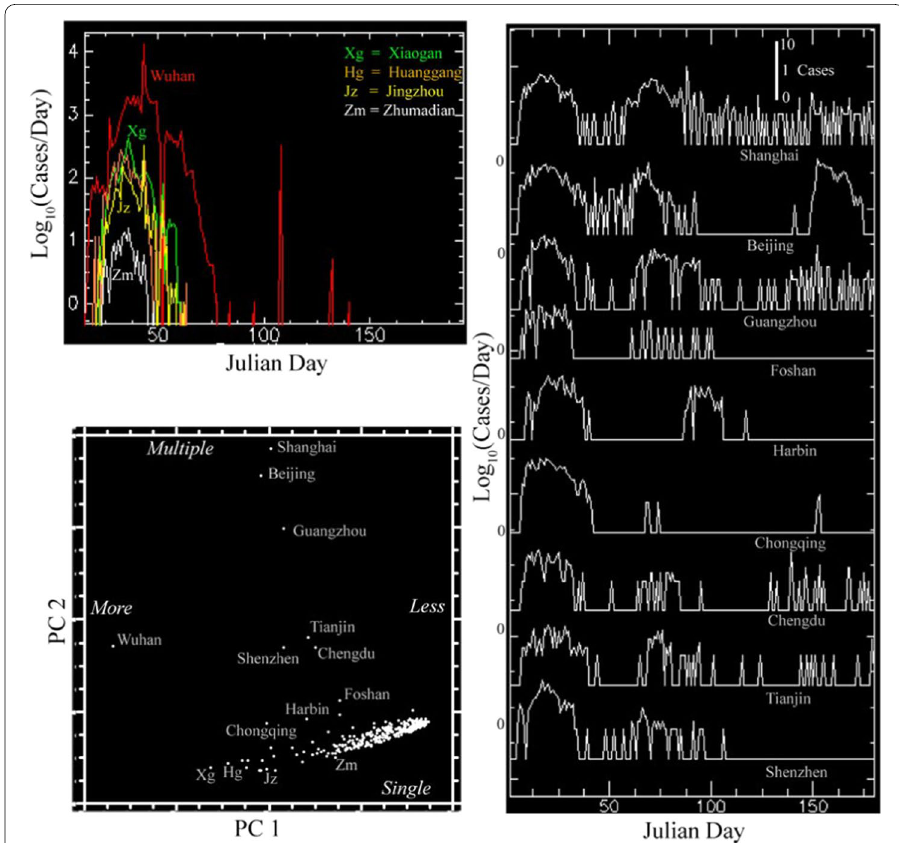
Fig. 11 Spatiotemporal analysis of case trajectories in China. The first Principal Component (PC1) clearly corresponds to total number of cases, while the second (PC2) distinguishes larger cities with multiple waves of cases lasting far longer than those observed for Wuhan and other cities in Hubei—which had much larger numbers of cases, albeit in single waves lasting 50 to 75